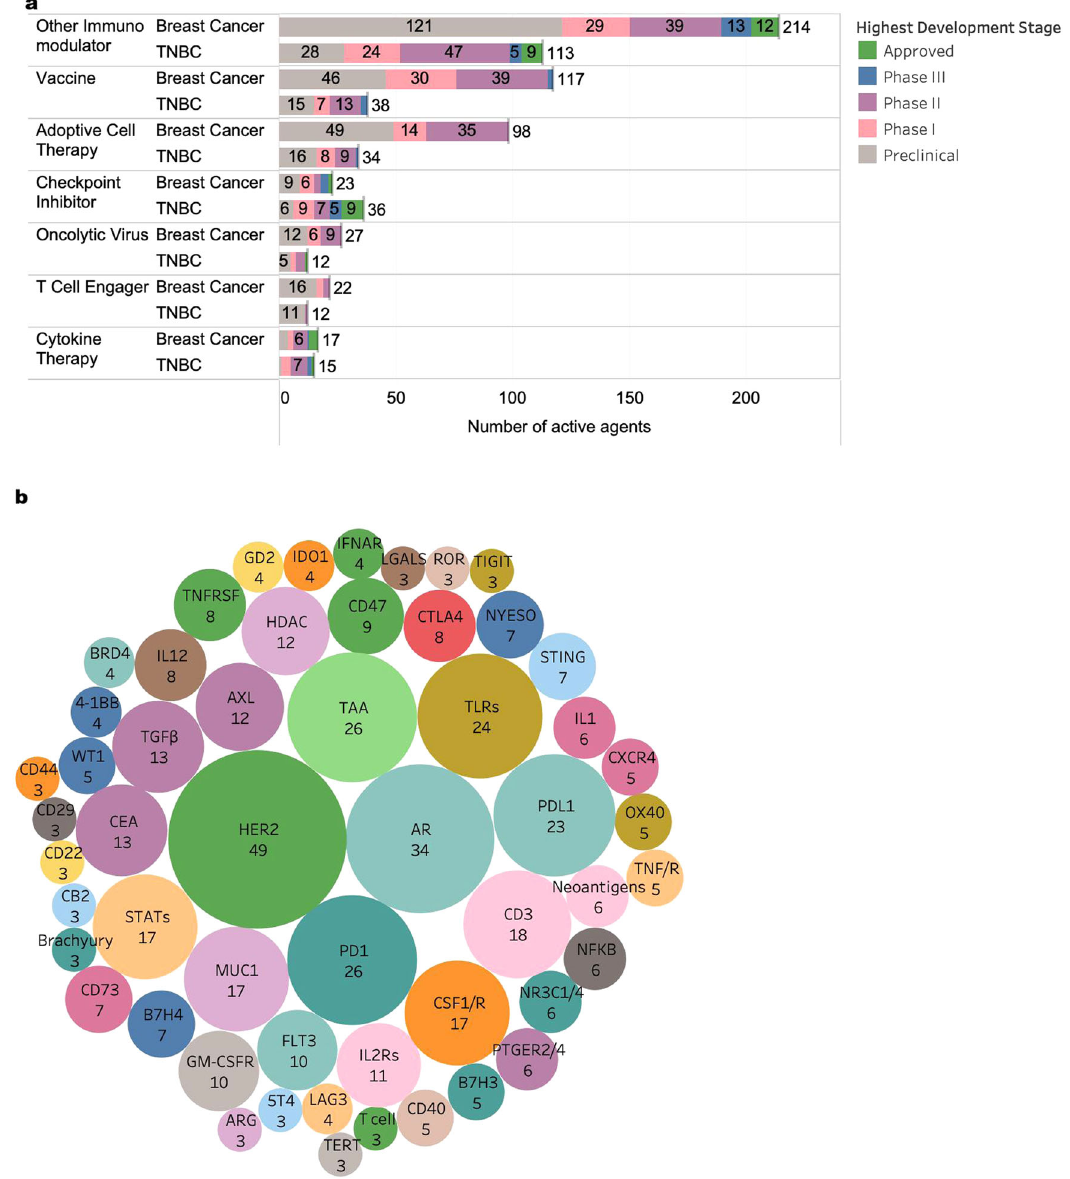
Fig. 1 Immuno-oncology (IO) agents in development for breast cancer and triple-negative breast cancer (TNBC). a Number of IO agents in active development that are being explored in breast cancer and TNBC. “ Checkpoint inhibitor ” category includes only PD-1, PD-L1, and CTLA- 4 targeted agents, while other immunomodulators that fall outside of “ vaccine ” , “ adoptive cell therapy ” , “ oncolytic virus ” , “ cytokine therapy ” , and “ T cell engagers ” are grouped into “ other immunomodulators ” . These include immunomodulators to natural killer cells, B cells, and other immune cells. b Most common targets of IO agents explored in breast cancer, where only targets with at least three agents in active development are shown. TAA tumor-associated antigens.